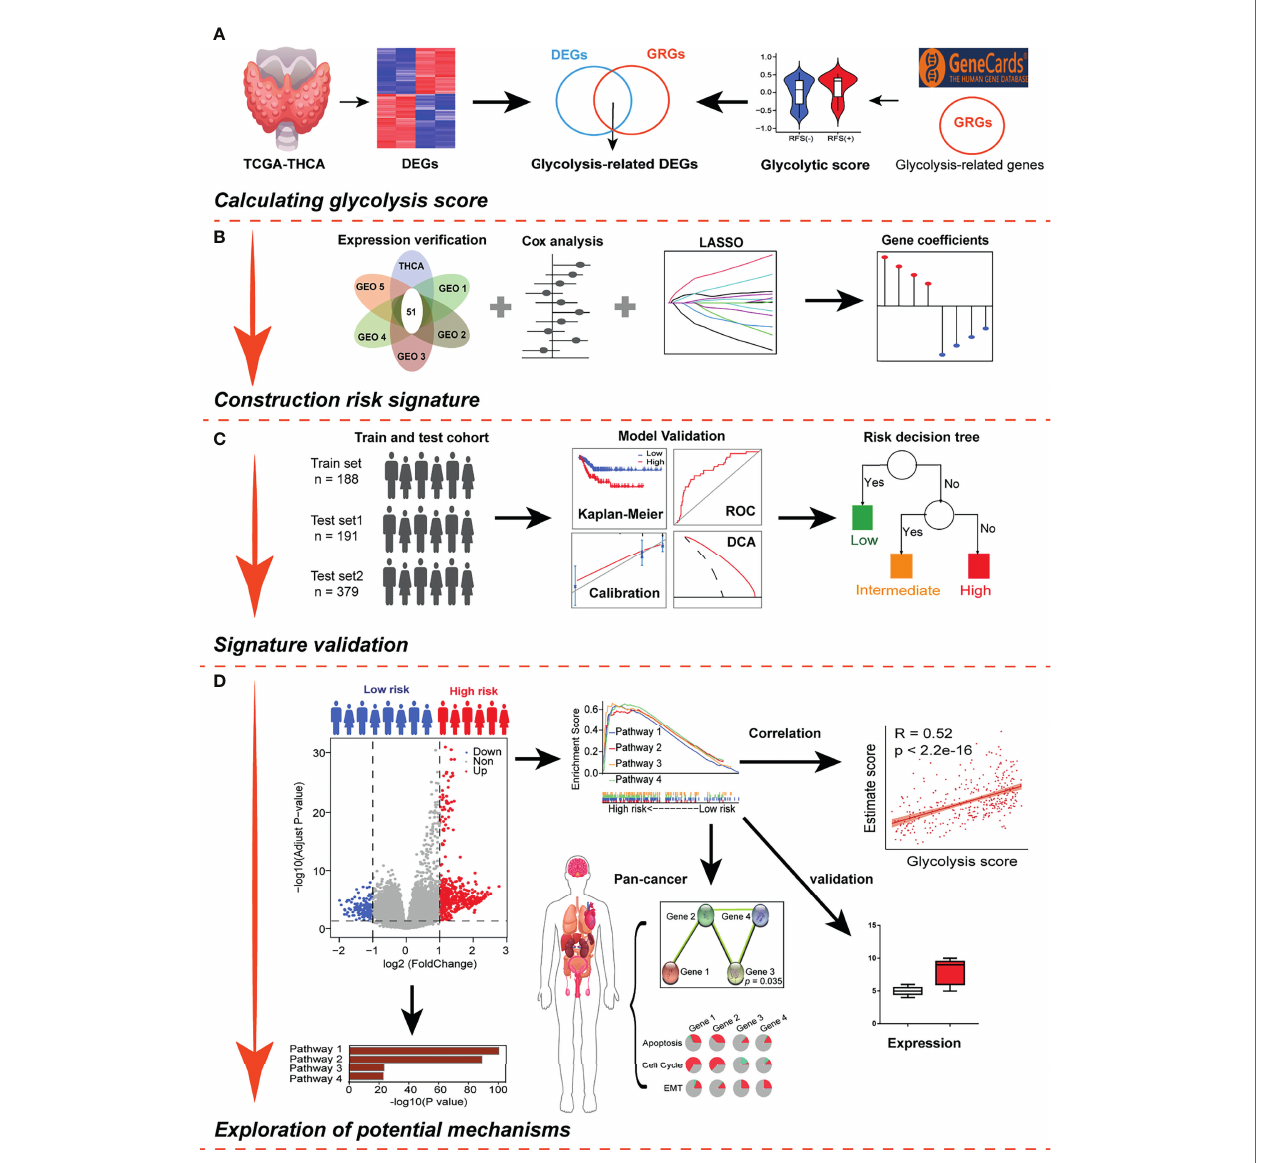
FIGURE 1 | Schematic work fl ow of the study design. (A) Glycolysis was identi fi ed as an important risk factor for recurrence-free survival (RFS) in differentiated thyroid carcinoma (DTC). (B) Combined methods were used to establish a robust glycolysis-related gene signature for prognosis. (C) The prognostic value of the gene signature was validated in different cohorts, and a clinical decision tree was generated. (D) Exploring potential molecular mechanisms using pan-cancer analysis and cellular